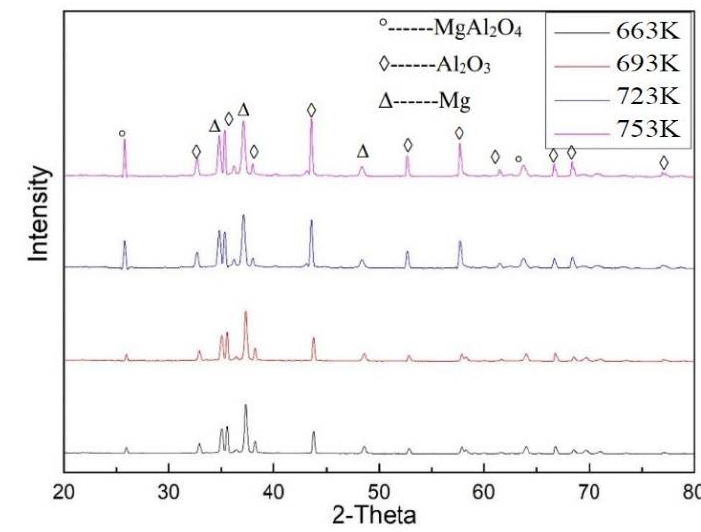
Figure 6. XRD patterns of Al 2 O 3hs /AZ91D.